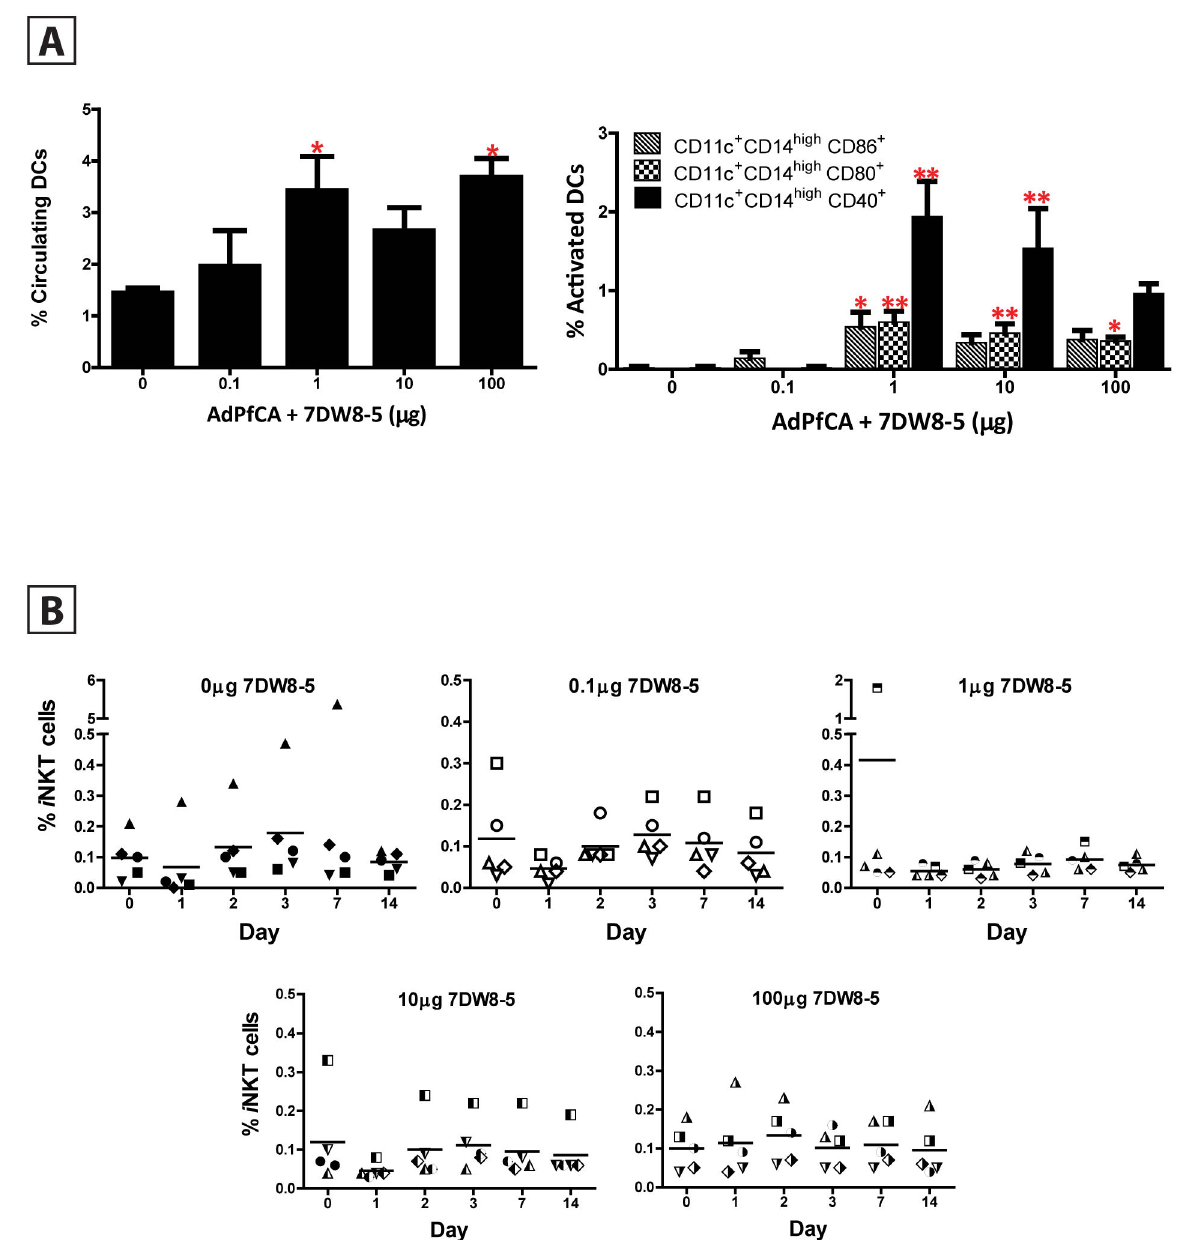
Figure 2. Activity of 7DW8-5 on DCs and i NKT cells in rhesus macaques. ( A ) Percentage of circulating and activated monocytoid DCs upon 7DW8-5 and AdPfCA co-administration in vivo . PBMCs were isolated 24 hours post prime and stained for circulating (left panel) and activated (right panel) DCs. Each column indicates the mean value for 5 animals per group; errors bars denote SEM. * = p < 0.05 and ** = p <0.01 when compared to control group receiving AdPfCA + 0 µg 7DW8-5. ( B ) AdPfCA administration with or without 7DW8-5 induces a transient decrease in the percentage of iNKT cells. PBMCs were isolated at baseline and up to 2 weeks post prime and stained for iNKT cells as described. Each point represents % iNKT cells from one animal; lines indicate mean % iNKT cells per dose group at the indicated time point. doi: 10.1371/journal.pone.0078407.g002 in the number or activation of monocytoid DCs among the different animals (data not shown).